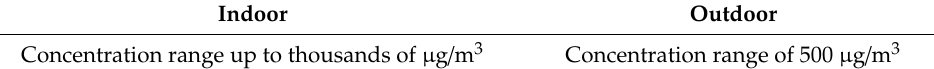
Table 1. Low-cost PM sensor node applications, both indoor and outdoor, extracted from the scientific literature investigations and web